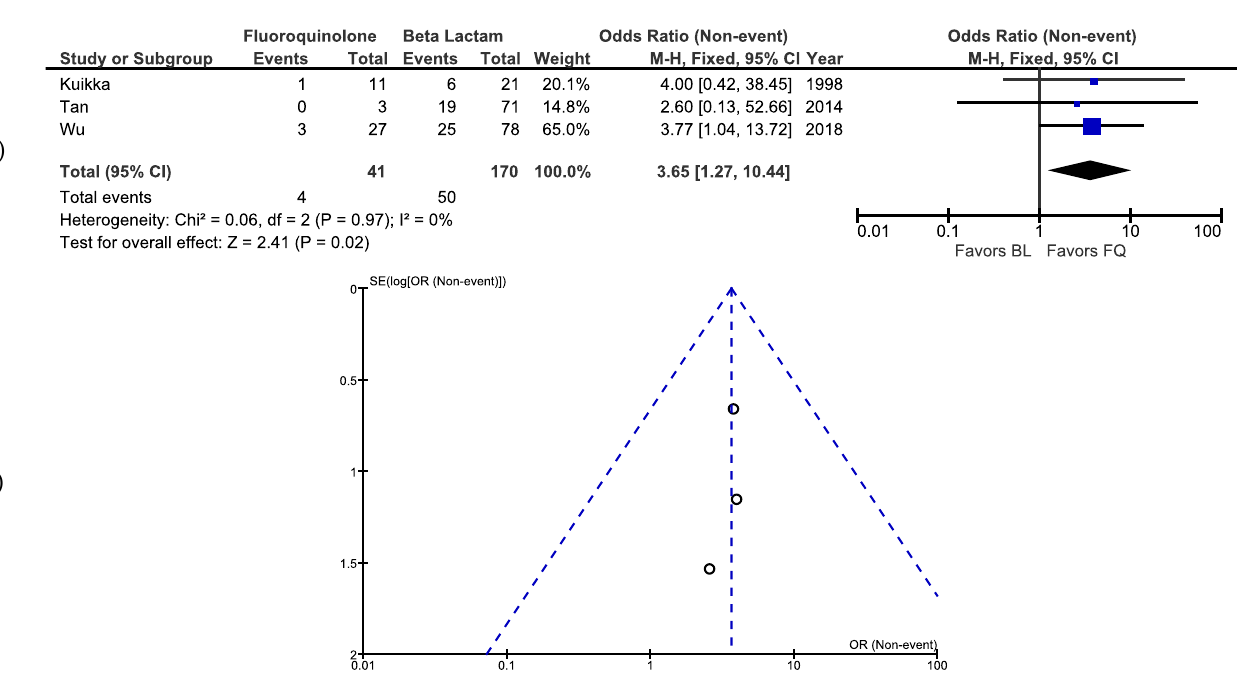
Figure 2. ( A ) Forest plot showing FQ monotherapy is associated with significantly improved survival compared to BL monotherapy using a fixed-effects model. ( B ) Funnel plot showing the studies included in the meta-analysis.